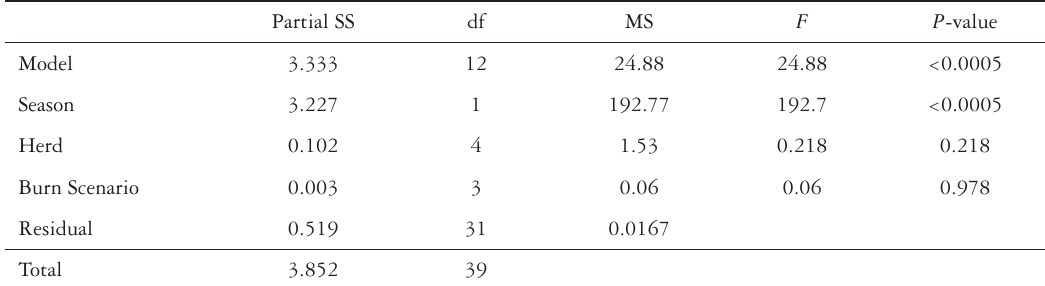
Table 2. ANOVA results for the effects of burn scenarios, season, and herd status on the percentage of caribou ranges occurring in high quality caribou habitat from RSF models, measuring the direct effects of fire on caribou. Seasons were winter and summer, and burn scenarios were prescribed burns, interior area, and buffer area burns. No interactions were significant. Overall adjusted R 2 for the model was 0.831, n =40 landscape burn experi- ments.